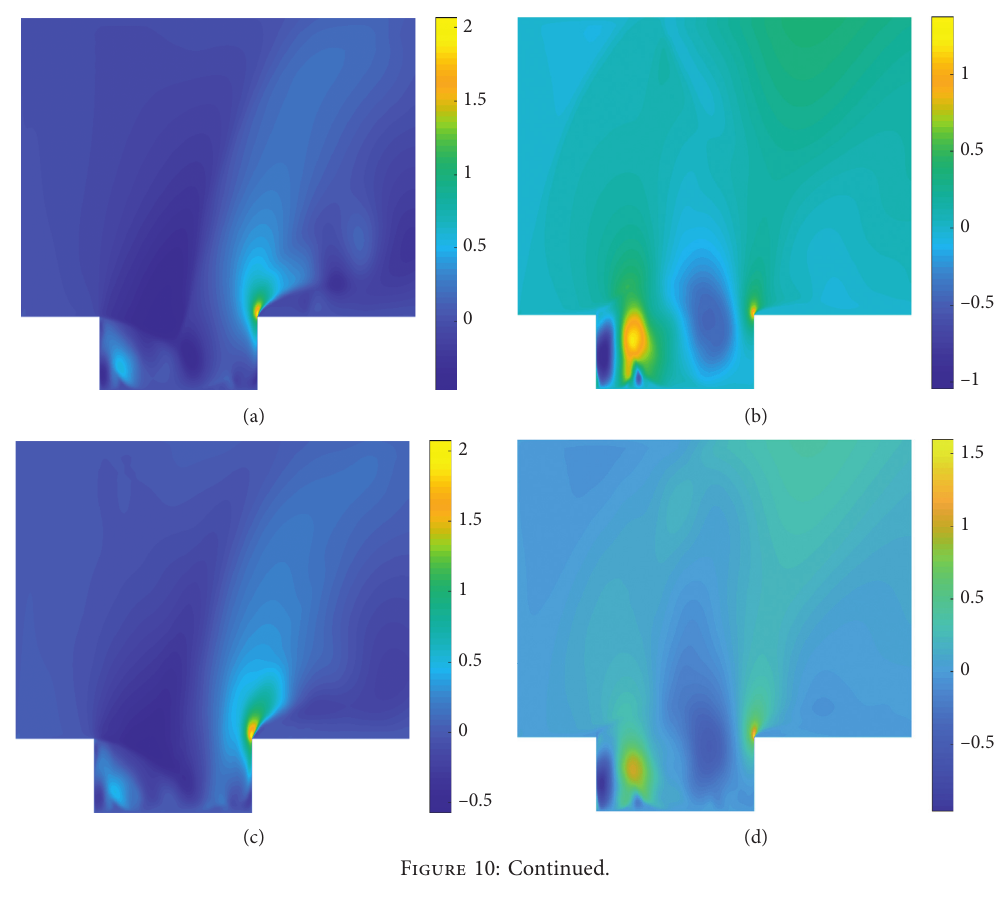
1 ( t ). (b) a 2 ( t ). (c) a 3 ( t ). (d) a 4 ( t